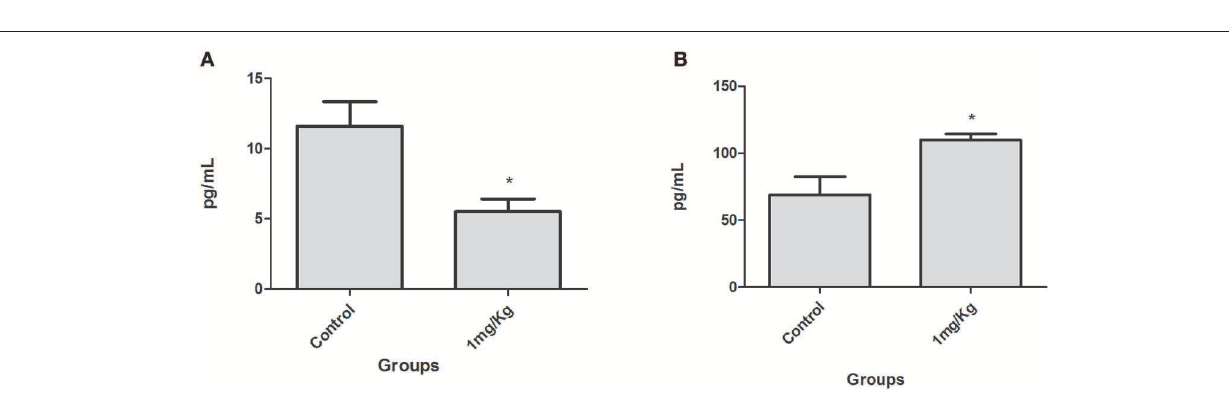
FIGURE 3 | Serum IL-6 (A) and chemokine MCP-1 (B) levels in BALB/c mice infected with L. (L.) infantum treated for 10 consecutive days with LP-SERT at a dose of 1 mg/kg. Cytokine levels (pg/ml) were determined by flow cytometry by the CBA kit (cytometric beads array—BD) (* p < 0.05). It was considered 10,000 events per analysis. The control is defined by infected and untreated